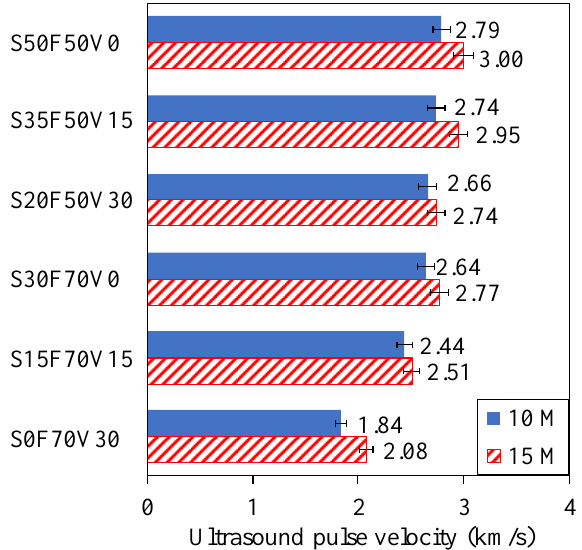
Figure 10. Ultrasound pulse velocities of the geopolymer mortar.